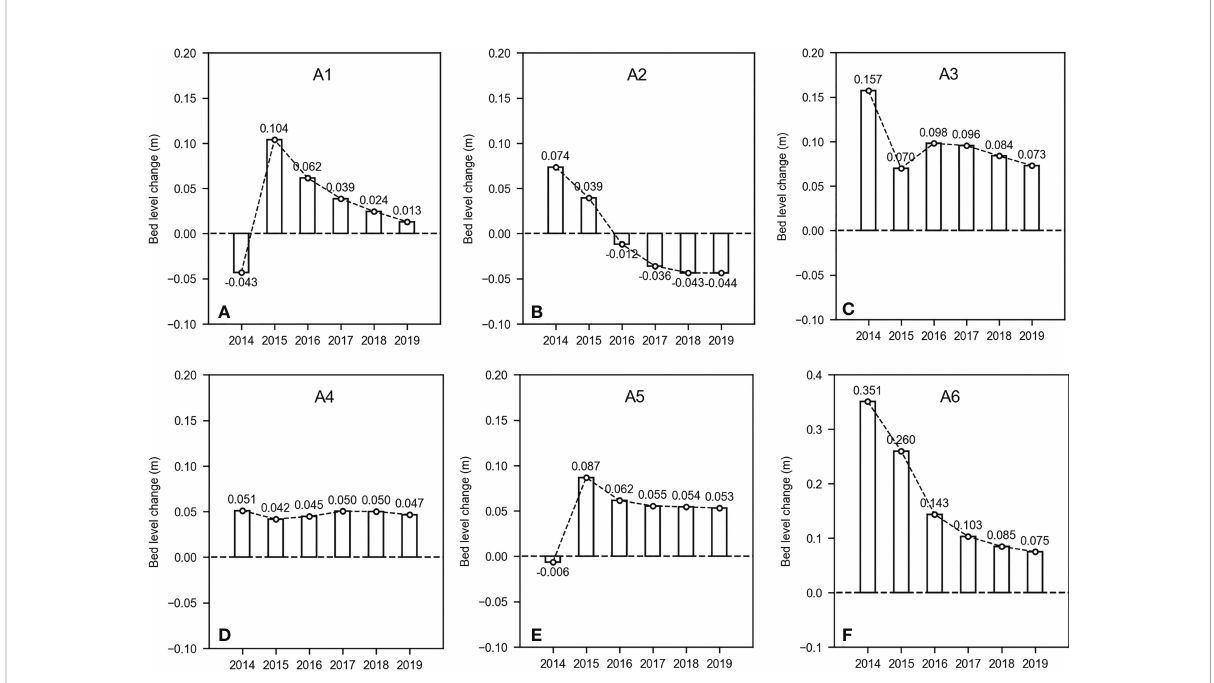
FIGURE 13 Annual variation of bed-level change intensity at characteristic points before and after human engineering activity. (A – F) Characteristic points A1 to